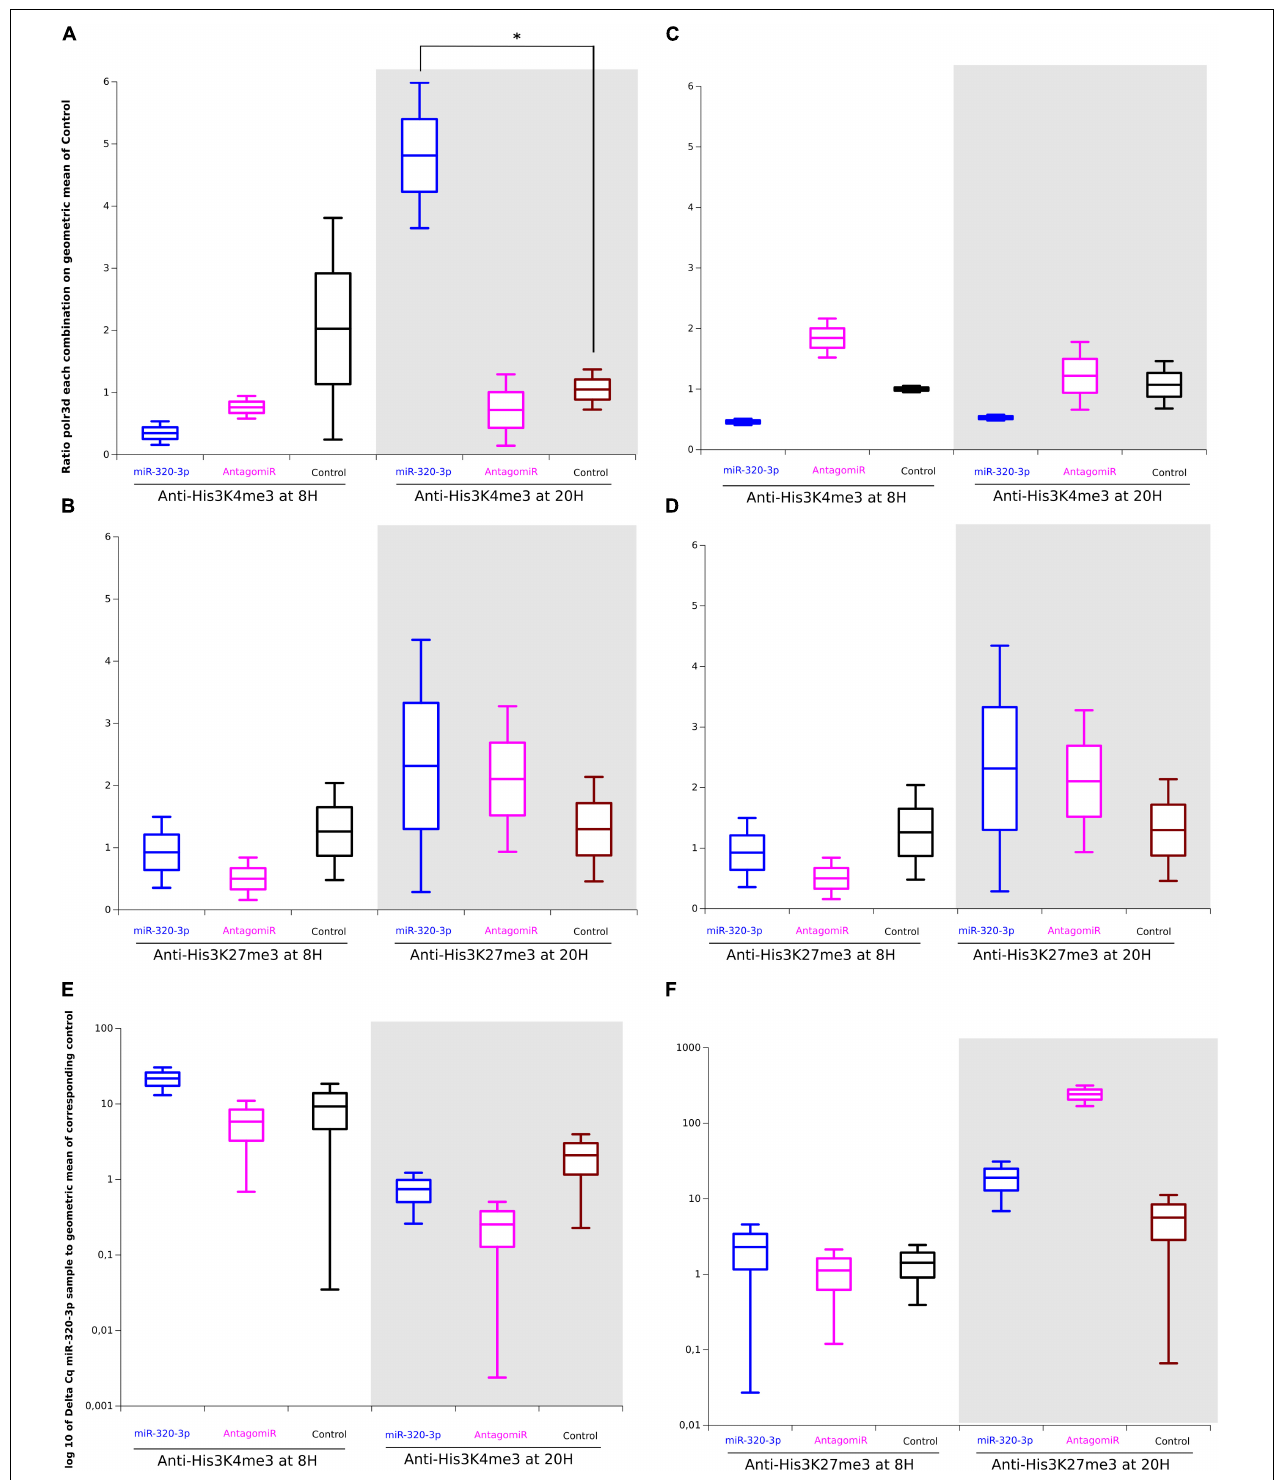
FIGURE 6 | Difference between Chromatin-ImmunoPrecipitation done with anti-Trimethyl-histone-3-Lys4 or Lys-27 on gastric tissues of rat pups treated per os , with miR-320-3p or antagomiR-loaded DOSP nanoparticles or control buffer. (A) Note a higher ratio of polr3d for miR-320-p group against Control group ( ∗ P = 0.05) at ZT-20H and the similarity of levels for AntagomiR and Control groups. In panel (B) parallel determinations of immune complexes H3K27me3 showed that only the antagomiR-320-3p group was slightly enriched in the polr3d promoter. The immune complexes for H3K4me3 The immune complexes for H3K4me3 at ZT-8H